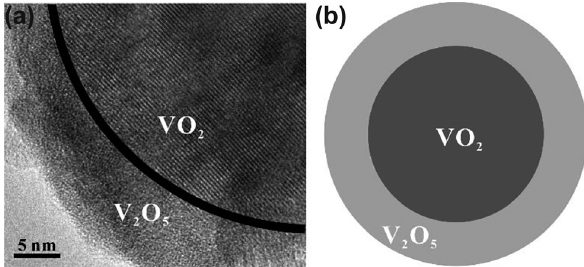
Figure 3: VO 2 /V 2 O 5 core – shell heterostructures. (a) HRTEM diagram. (b) Schematic diagram of the core – shell